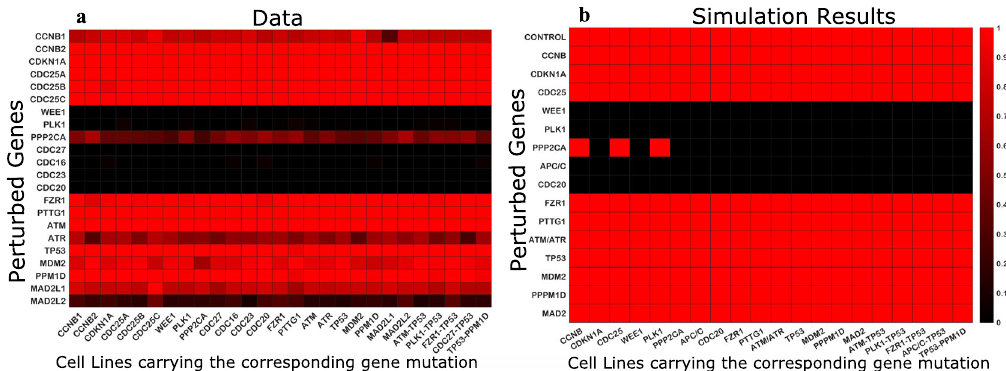
Fig. 5 Heatmaps showing the gene perturbation results in different cancer cell lines. a The results derived from CRISPR (Avana) Public 20Q4 perturbation data analysis. The data were downloaded from Cancer Dependency Map database (depmap.org). b The model simulation results. The perturbed genes are listed along the y -axis, the cell lines carrying mutations in speci fi c genes listed along the x -axis. The color scale shows whether the gene is reported essential or not. The black color shows that a gene is essential and the red color shows that a gene is not essential. For the heatmap representing the experimental data ( a ), we counted how many times a gene is reported as essential in each cell line carrying a speci fi c gene mutation. For example, PLK1 gene is reported to be essential in all cell lines (black line), while ATR gene is essential in most cell lines carrying CCNB1 gene mutation (the heatmap rectangular cell is colored closer to black than red) but not in cell lines carrying CCNB2 mutation (the heatmap rectangular cell is colored closer to red than black). For the model results ( b ), the rectangular cell of the heatmap is colored black if a cell cycle arrest was observed and is colored red if the normal cell cycle progression was observed when genes were perturbed. The control represents unperturbed cancer cells. All unperturbed cancer cell lines were observed to be progressing through the cell cycle, thus are shown by red colored rectangular cells of the heatmap on the